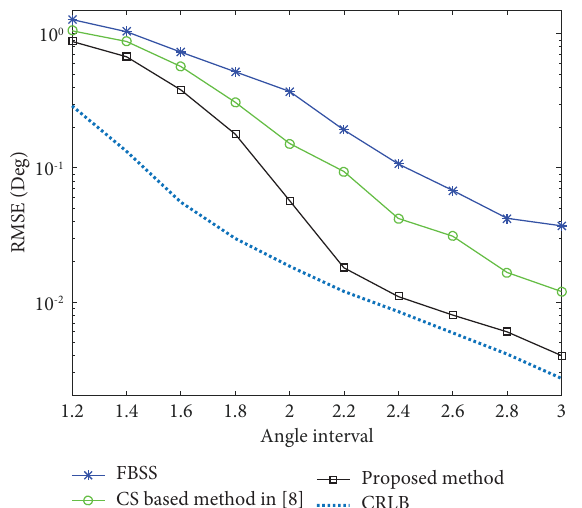
Figure 4: RMSE of the DOA estimation vs diferent angular